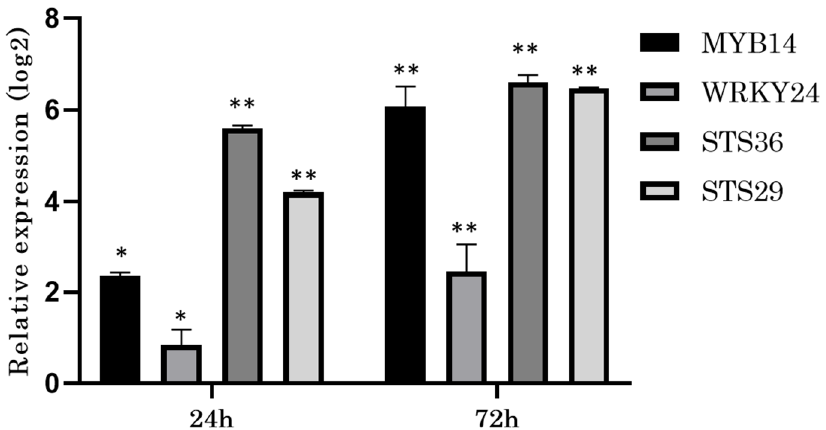
Figure 5. Analysis of expression of two grapevine STS paralogs and the TFs VvMYB14 and VvWRKY24 in Gamay cell cultures in response to CD elicitation. RT-qPCR analysis of VvSTS36 , VvSTS29 , VvMYB14 , and VvWRKY24 in Gamay cell cultures treated with 50 mM of CD at 24 and 72 h of incubation. Expression levels were normalized to VvEF1-alpha , and represented as relative expression to control treatment. (* p -value < 0.05; ** p -value < 0.01).